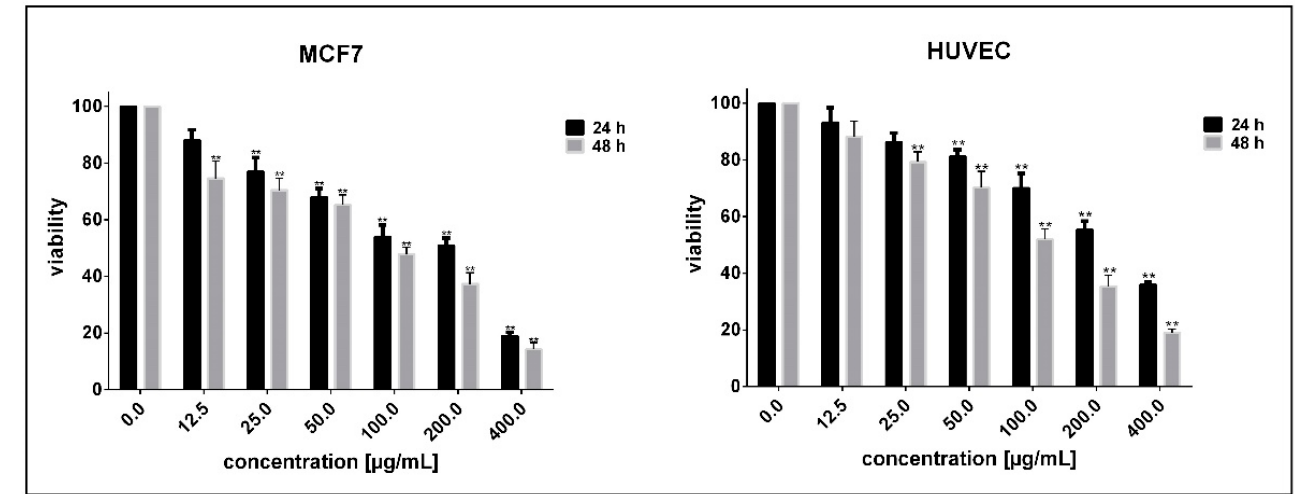
Figure 5. Time- and concentration-dependent toxicity of CoNiFe NPs on Michigan Cancer Foundation-7 (MCF7) and human umbilical vascular endothelial cells (HUVECs) using MTT colorimetric assay following 24 and 48 h incubation. Data are expressed as mean ± SD from one representative of three independent experiments. (** p < 0.05 compared with untreated cells).